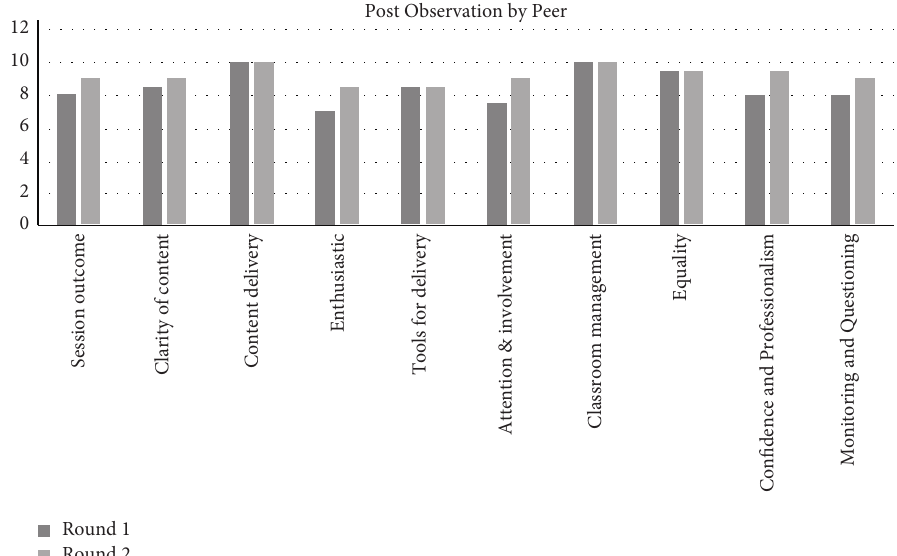
Figure 3: Postobservation by peers in round 1 (dark grey bars) and round 2 (light grey